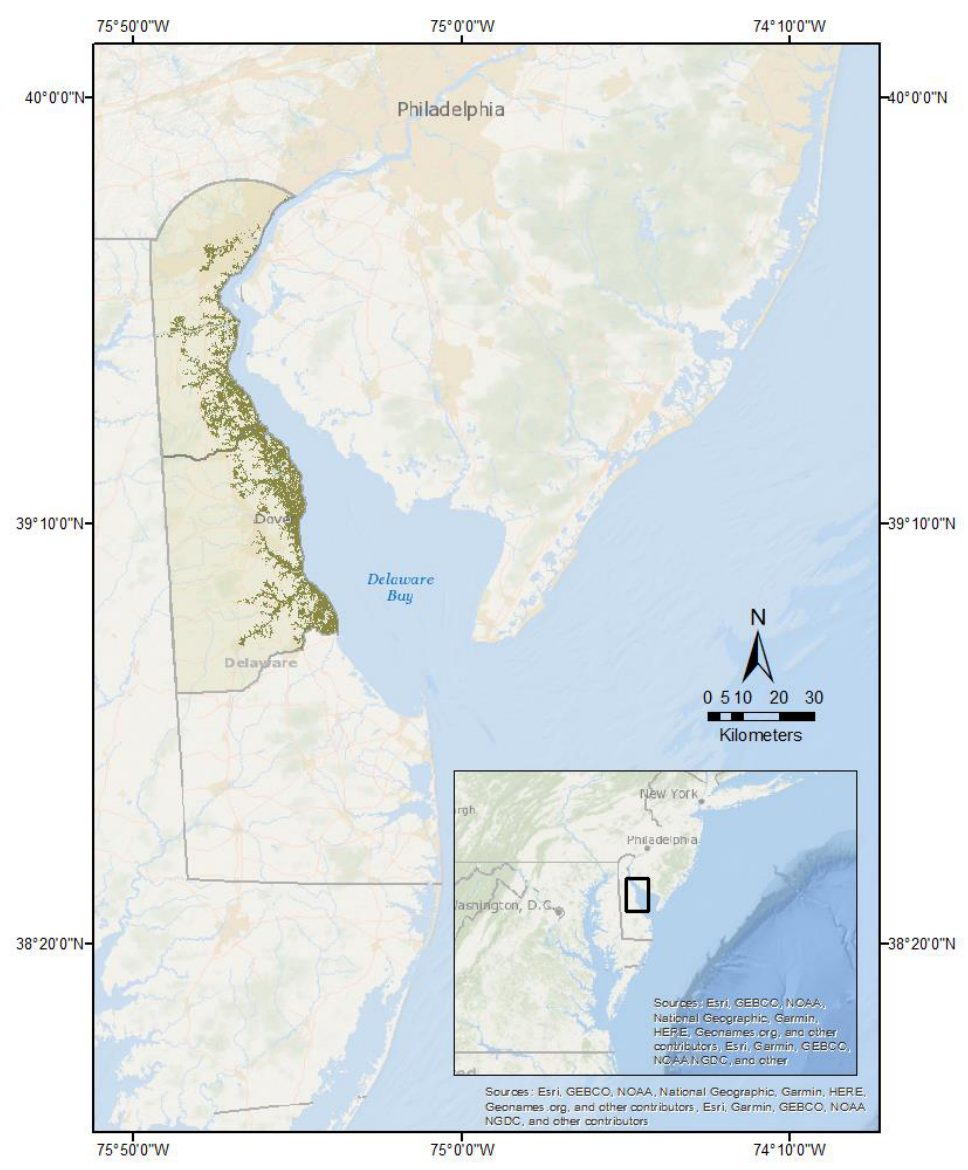
Figure 2. Map of the study area, coastal areas of New Castle and Kent Counties Delaware.